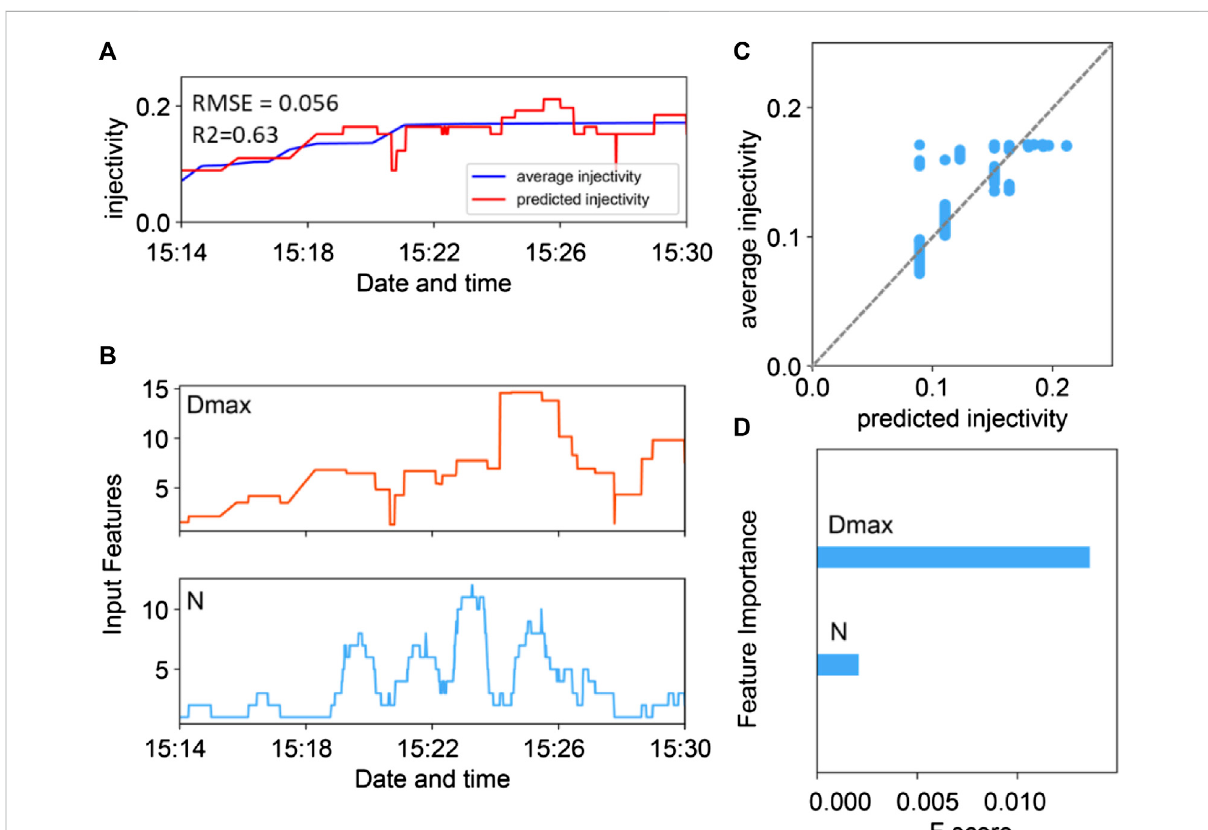
FIGURE 4 Predicted injectivity of episode #4. (A) Average injectivity by the time moving window (blue line) and predicted injectivity (red line) from the ML model in episode #4. (B) The input features are used to construct the machine learning model. (C) Average permeability vspredicted permeability in episode #4. (D) The importance of input